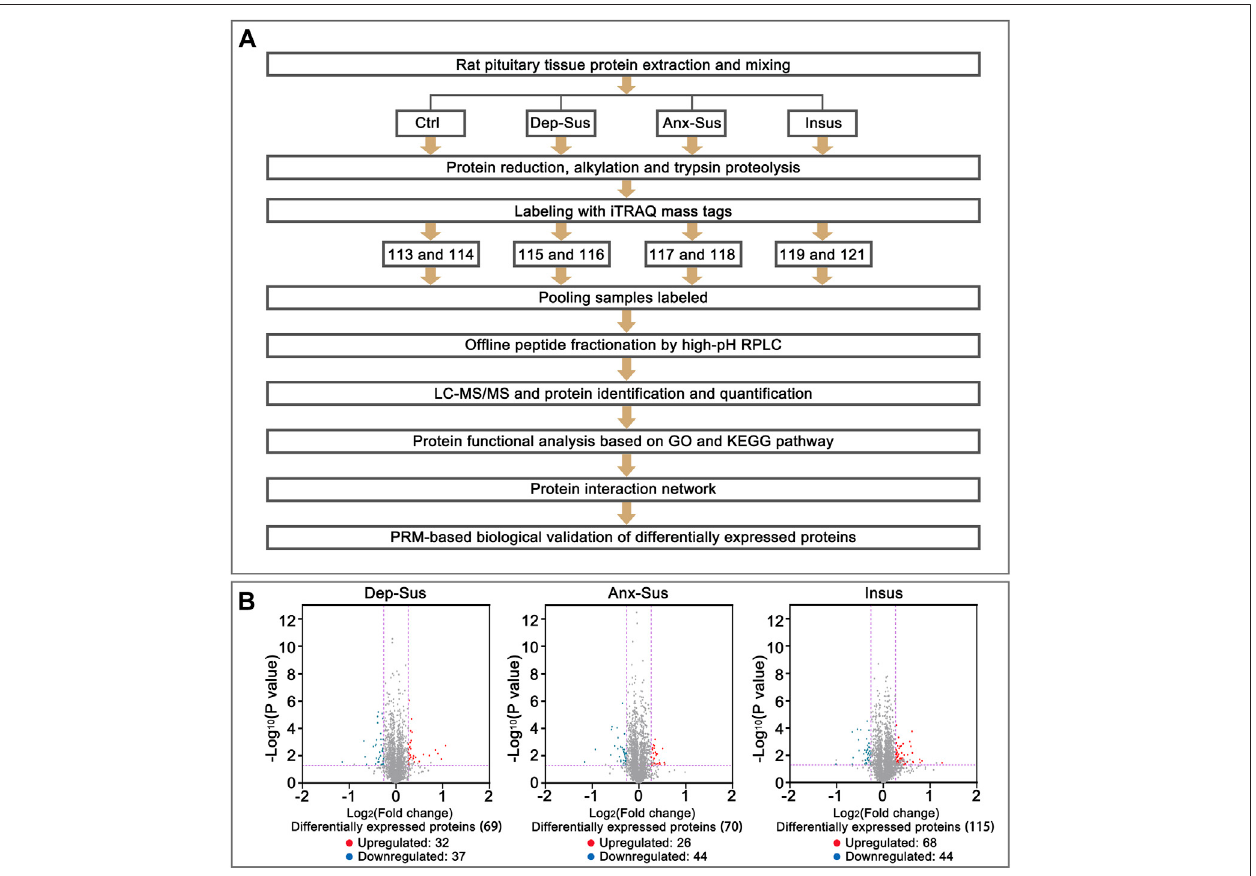
FIGURE 1 | Comparative analysis of the pituitary proteomic response of the rats under chronic mild stress (CMS). (A) Schematic representation of quantitative proteomics analysis of the control (Ctrl), depression-susceptible (Dep-Sus), anxiety-susceptible (Anx-Sus) and insusceptible (Insus) groups. (B) Volcano plot of the protein expression changesinthe three groups. Involcanoplot, thered plot representedup-regulatedproteins,and the blue plotrepresenteddown-regulated proteins. The x-axis shows the log2-transformed average fold change. The y-axis shows the negative log10-transformed p -value.